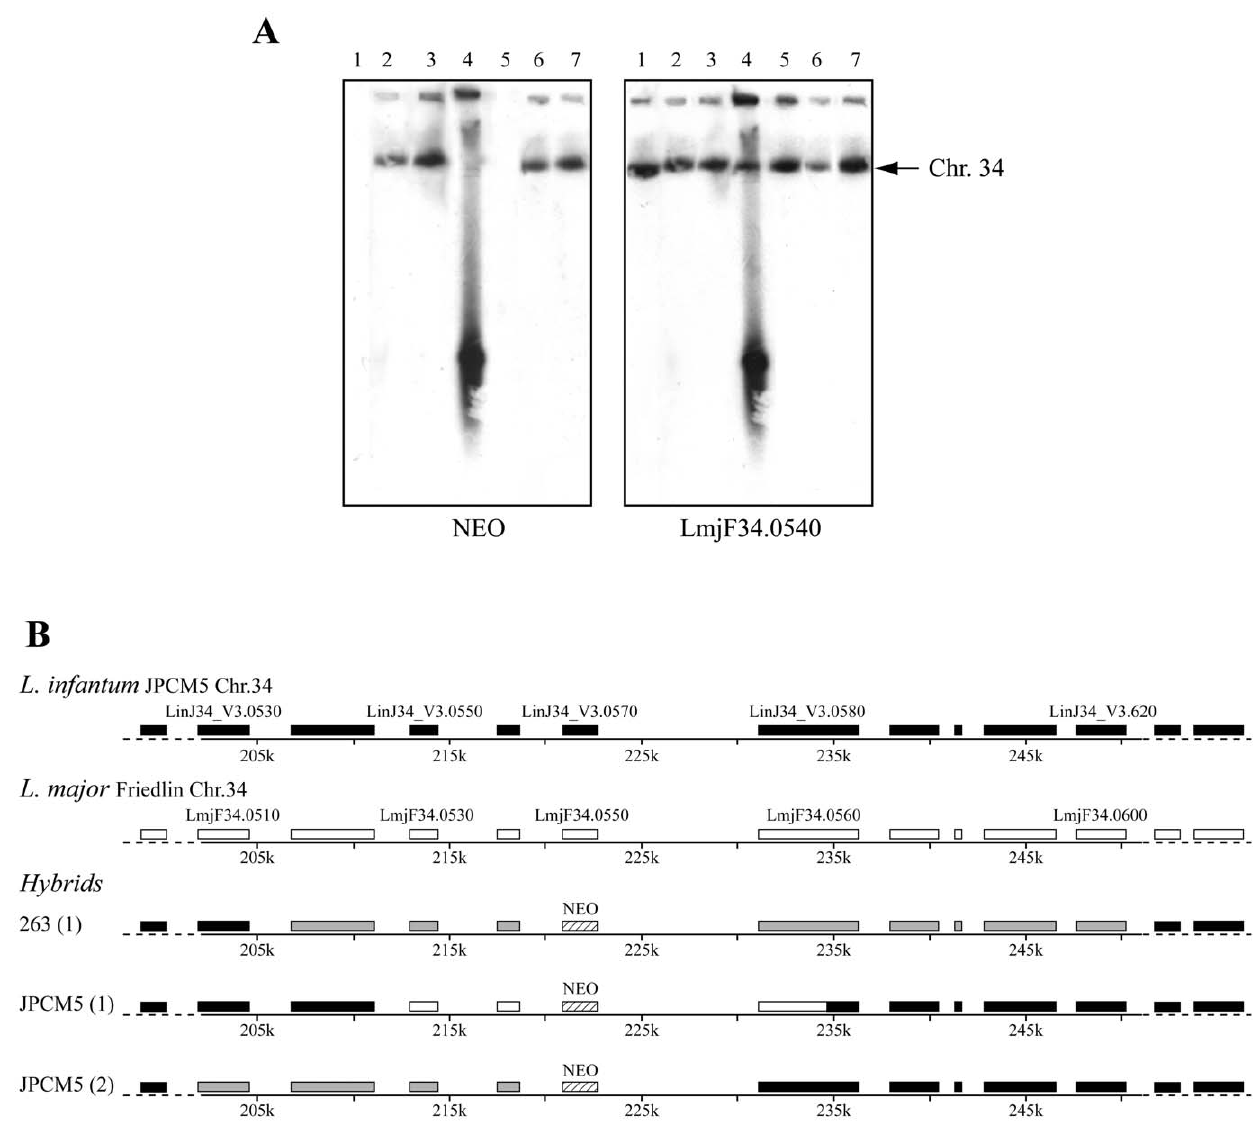
Figure 2. Whole genome transformation in Leishmania and cross-species hybrid formation. Genomic DNAs derived from LRP haploid mutants of L. infantum 263 (Li263 D LRP ::NEO/LRP) or L. major Friedlin (Lm D LRP ::NEO/LRP) were used to transfect L. infantum 263 or L. infantum JPCM5 (WT) parasites. (A) Chromosomes were separated by CHEF, transferred, and hybridized with probes specific for the NEO gene or for LmjF34.0540 gene located just upstream of the LRP gene on chromosome 34. The 2,000 kb chromosome 34 is indicated by an arrow on the right. Lane 1, L. infantum 263 WT; Lanes 2–4, L. infantum 263 transfected with Li263 D LRP ::NEO/LRP gDNA (2); Lm D LRP ::NEO/LRP gDNA (3–4); Lane 5, L. infantum JPCM5 WT; Lanes 6–7, L. infantum JPCM5 transfected with Li263 D LRP ::NEO/LRP gDNA or with Lm D LRP ::NEO/LRP gDNA, respectively. (B) Schematic map of the genomic region encompassing the LRP gene of L. infantum JPCM5 (black boxes) and L. major Friedlin (white boxes). Hybrids with one allele of L. major and one allele of L. infantum are shown in gray. The genomic regions exchanged in the hybrids were mapped by sequencing individual amplified genes using primers amplifying both L. major and L. infantum genes (Tables S3, S4, S5) located in the vicinity of the integrated NEO marker. The sequence of the hybrid JPCM5 (1) was also obtained by next generation sequencing. The extent of the genomic DNA exchanged is indicated after sequence analysis. In the JPCM5 clone 1 hybrid, both L. infantum alleles were replaced by L. major .